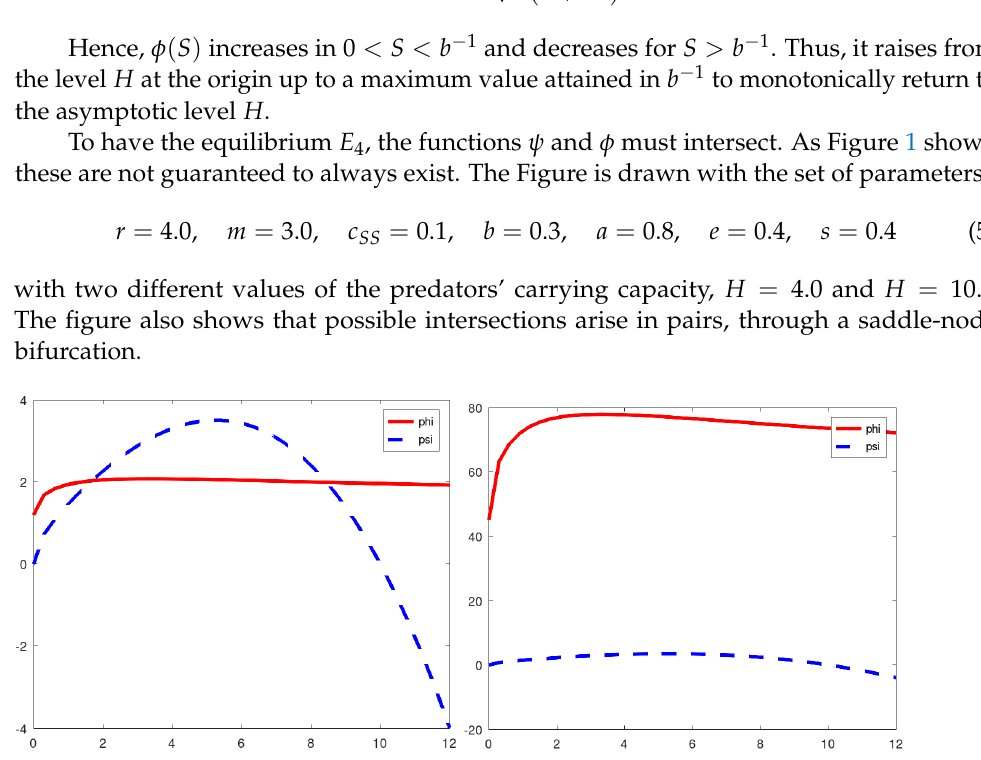
Figure 1. The functions φ ( S ) (blue) and ψ ( S ) (red) in two different possible configurations, showing that their intersections are not always guaranteed to be feasible for the parameters (5). Left frame : H = 4.0; and Right frame : H =